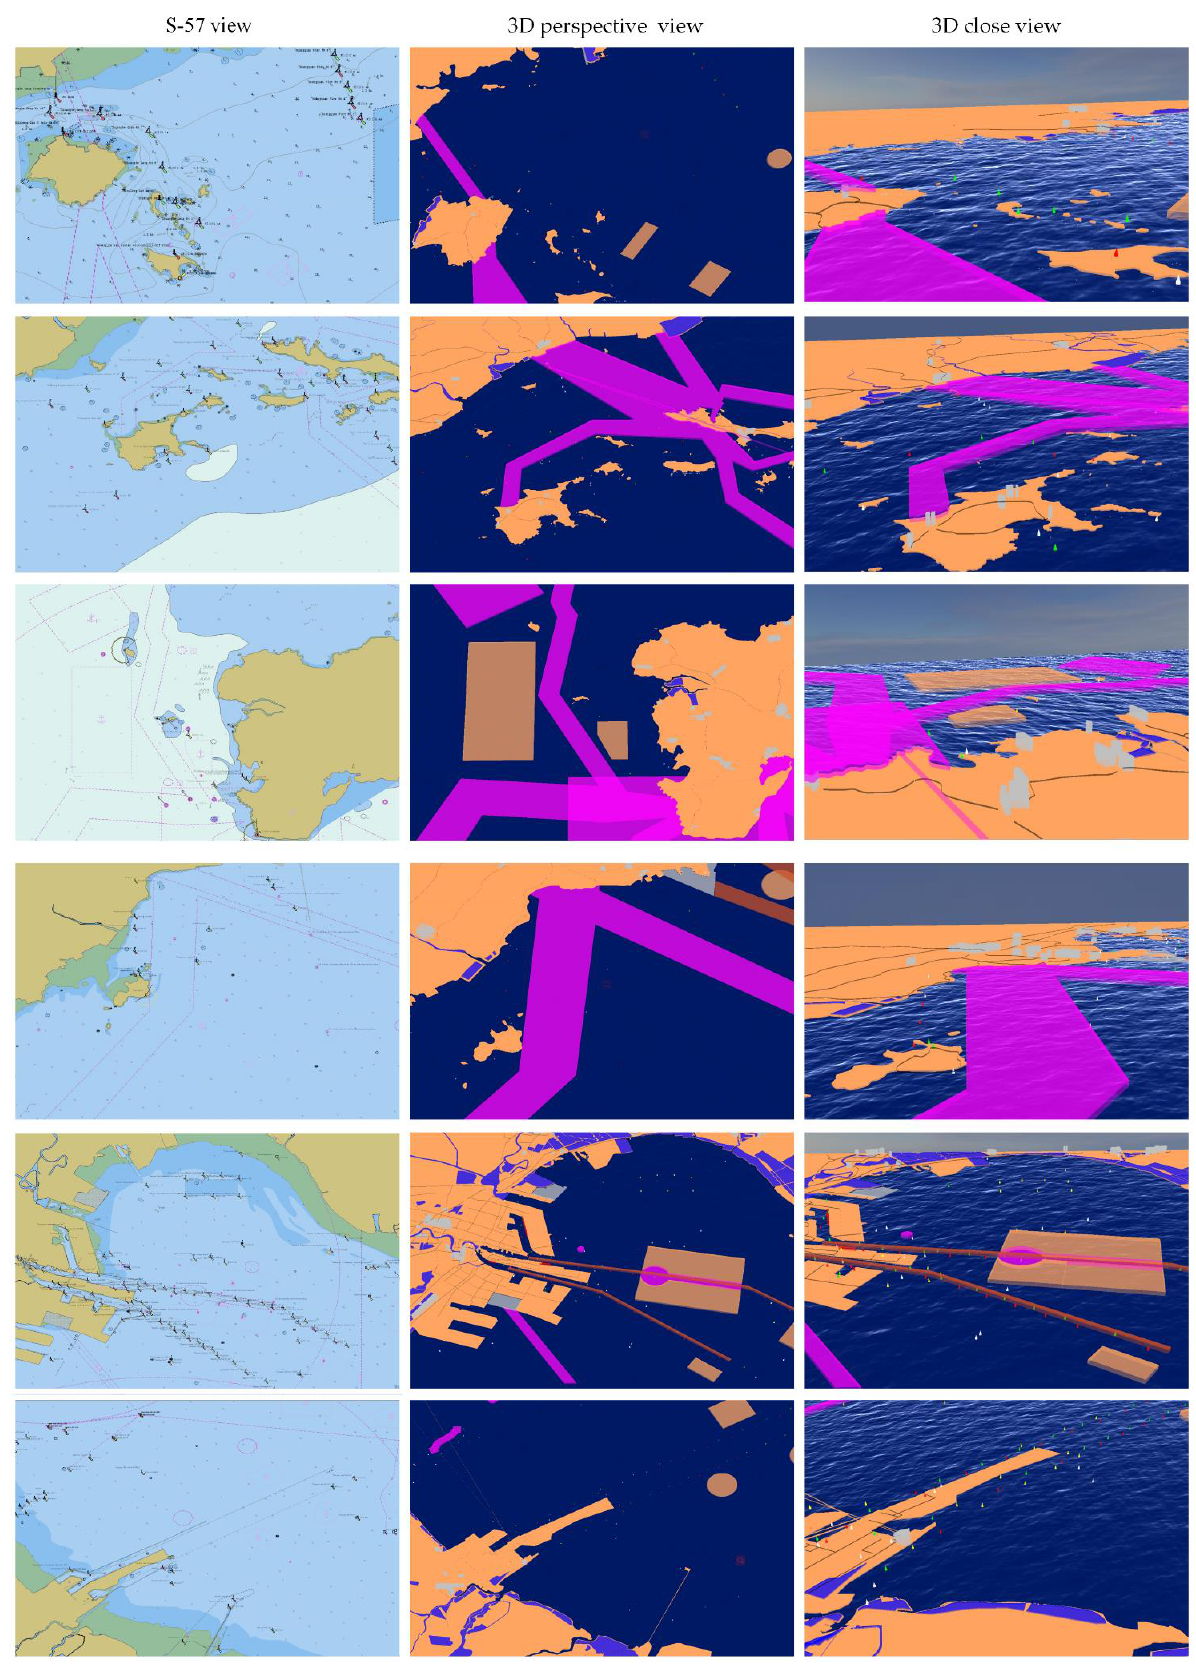
Figure 13. Visualization of the 3D ENC.